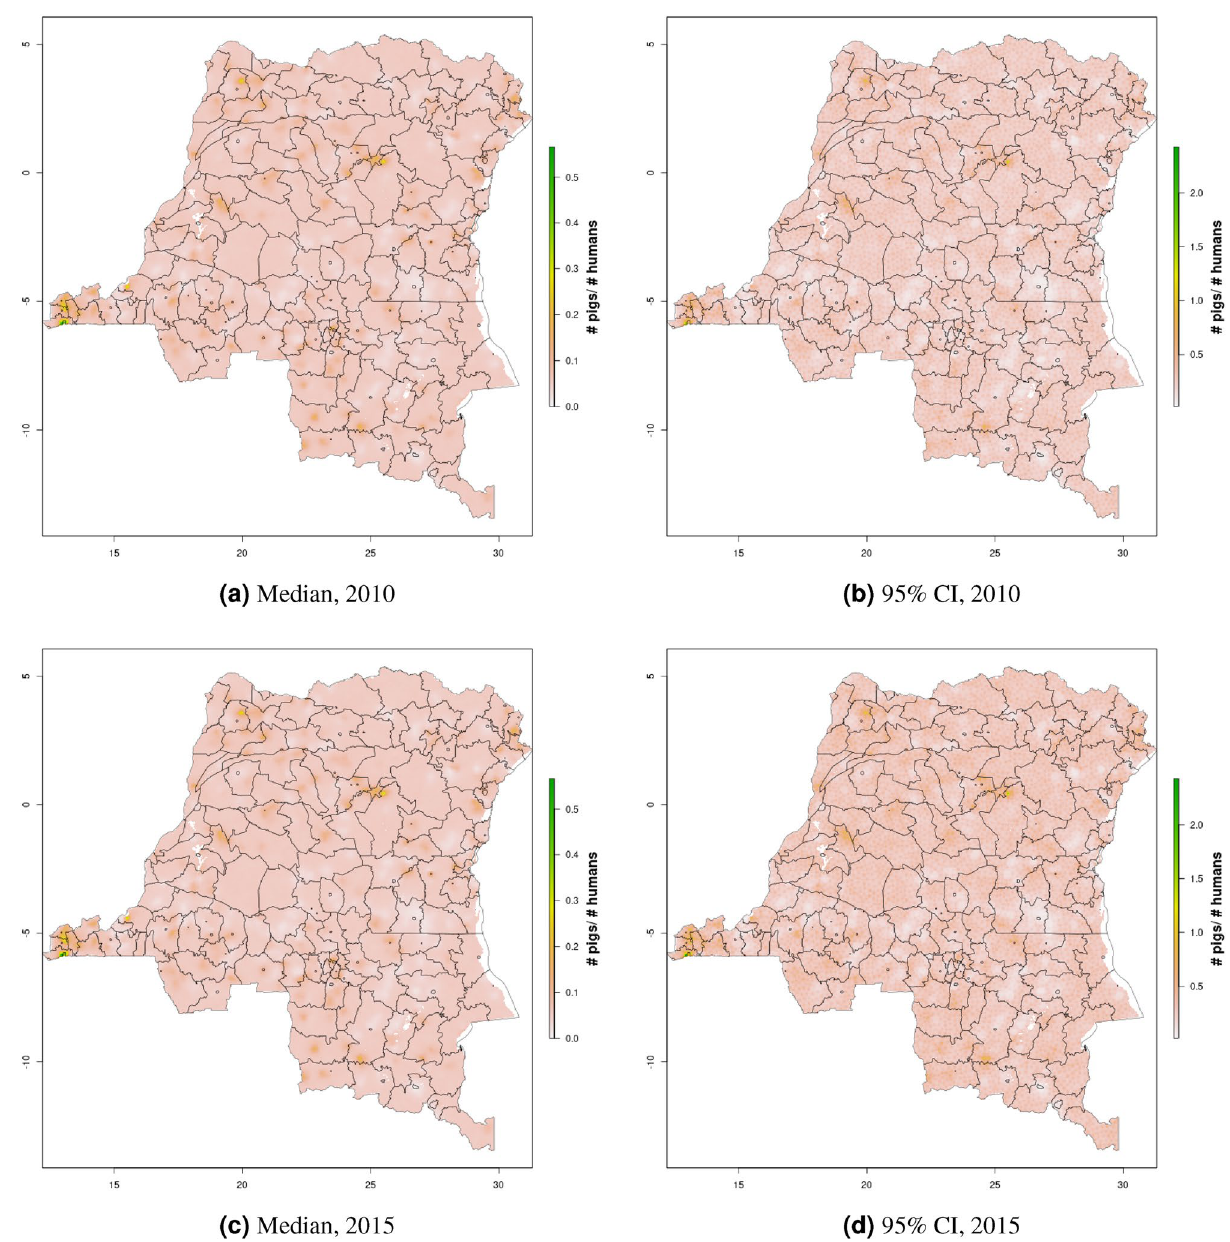
Figure 9. Pig density mapping results, DRC, 2010 and 2015. Median ( a, c ) and width of posterior 95% credible interval ( b, d